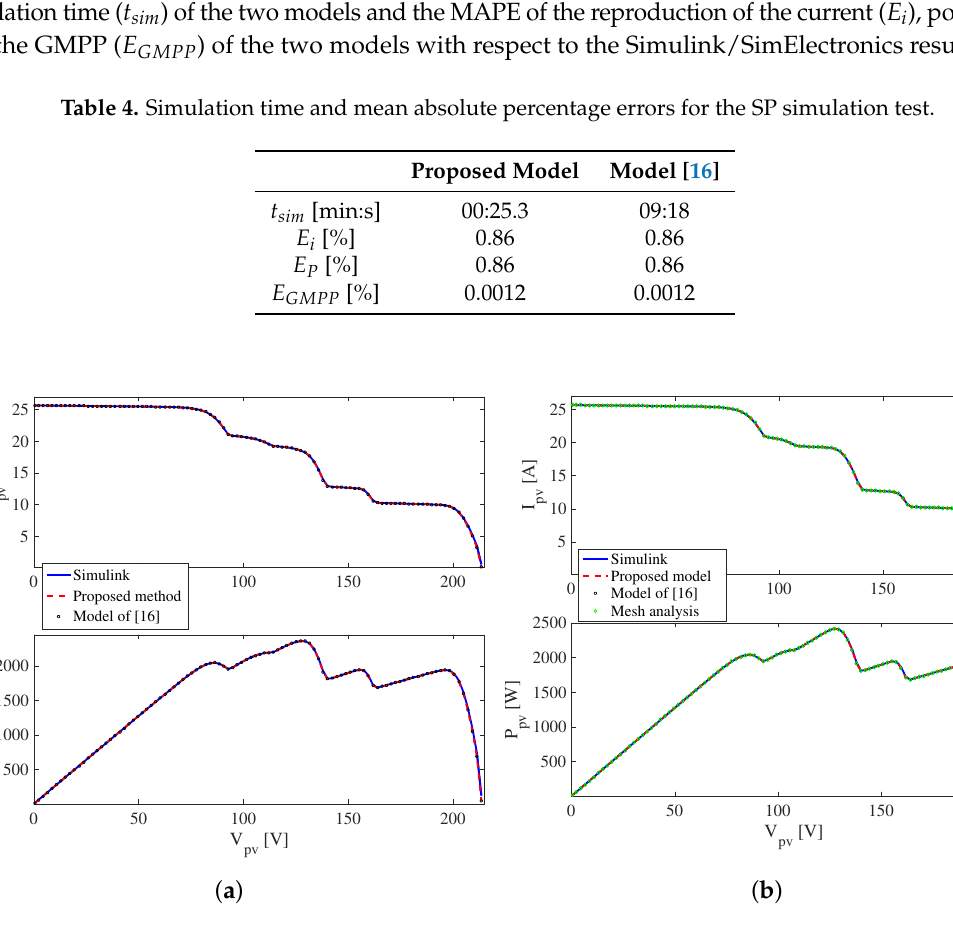
Figure 10. The circuital simulation, the proposed solution, and the procedure introduced in [16]: ( a ) the SP array; ( b ) the irregular array in Figure